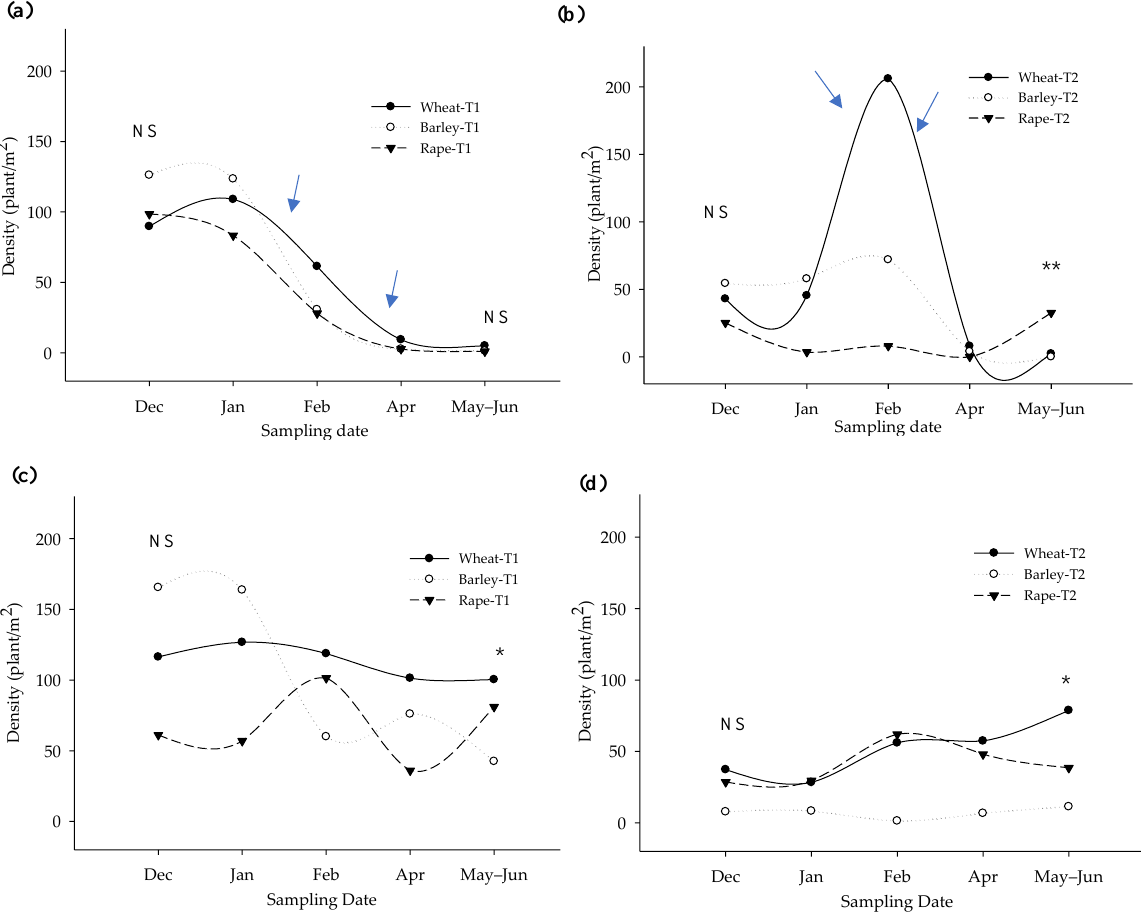
Figure 4. Evolution of G. coronaria densities (plants/m 2 ) across 2017 – 2018 growing season, as influenced by tillage ×crop interactions, ( a , b ): herbicide treated plots; ( c , d ): non-treated plots. The arrows indicate the timing of herbicide application. The symbols indicate the significance level at p = 0.05: * < 0.05, ** < 0.01 and NS > 0.05.